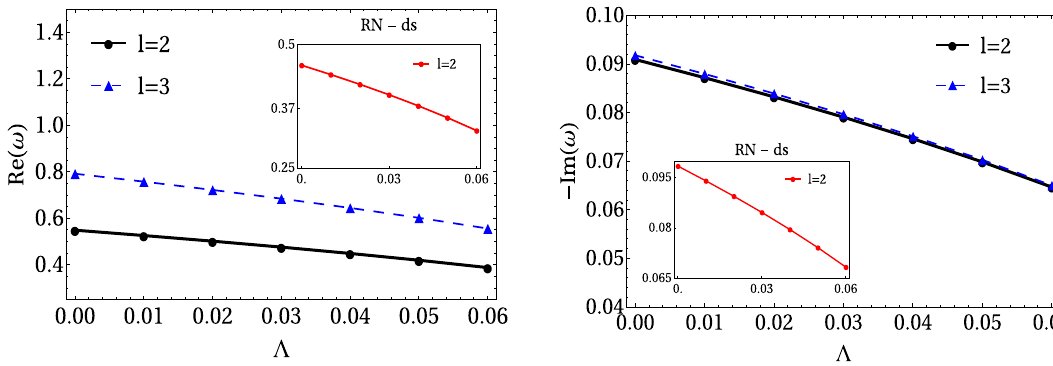
Fig. 5 Variation of Re( ω ) and -Im( ω ) vs (cid:2) with a fixed value of magnetic charge q = 0 . 4